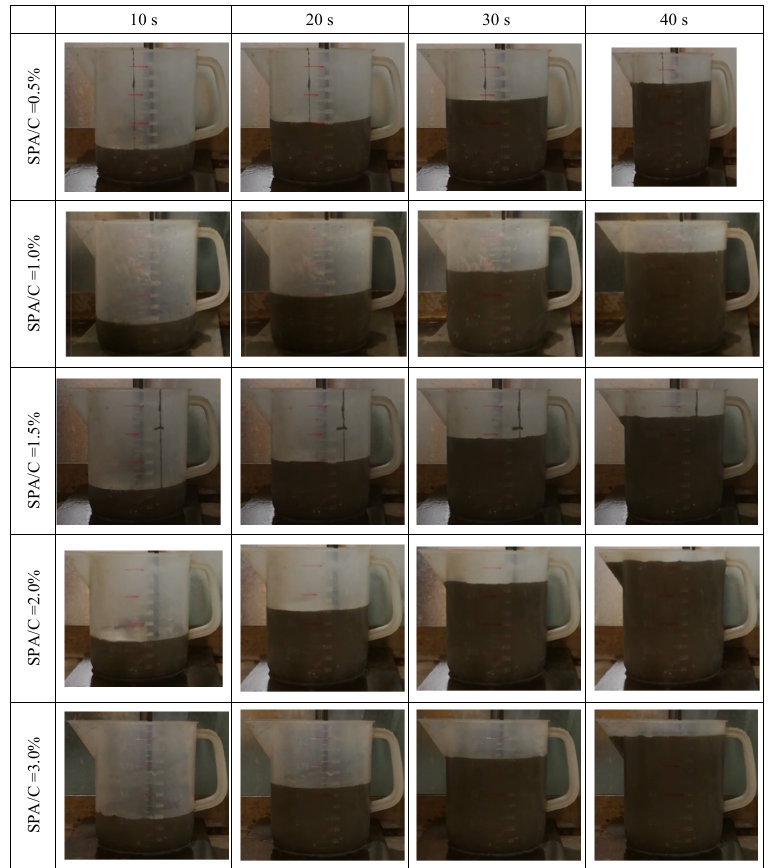
Figure 8. Volume of cement paste passing through the marsh cone as a function of the SPA/cement (SPA/C) ratio and the elapsed time with a w/c of 0.4.